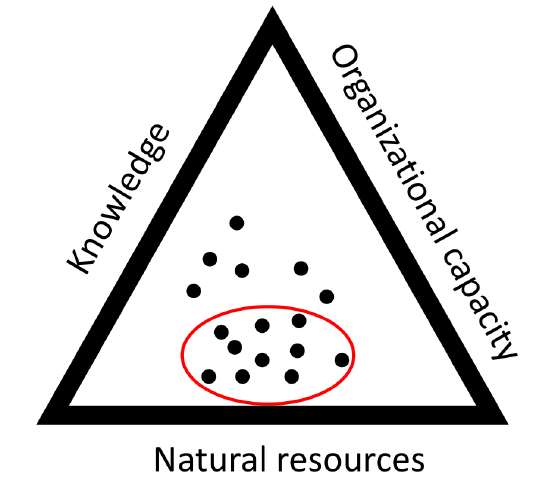
Fig. 1 . Three major aspects of material